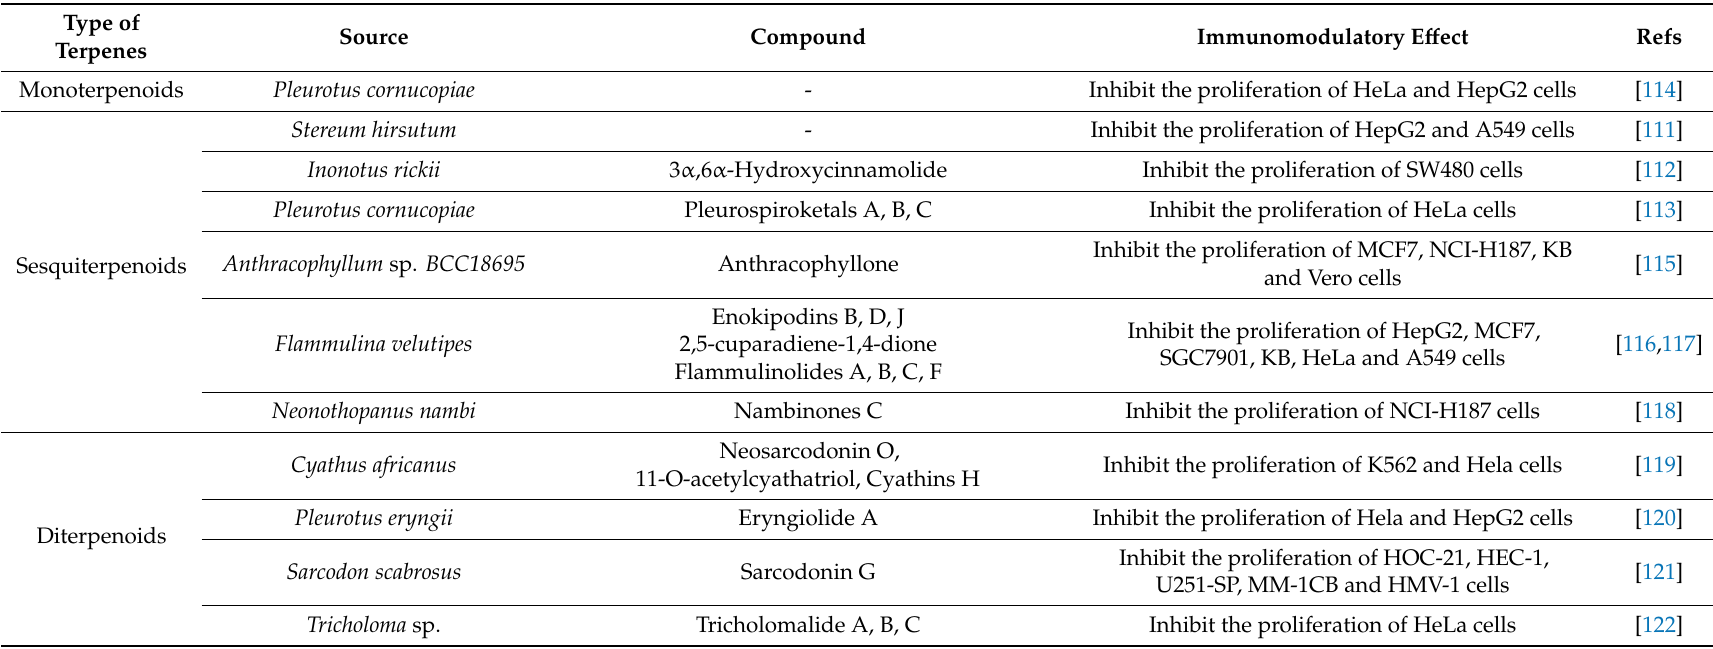
Table 5. Major immunomodulatory terpenes and terpenoids from medicinal mushrooms and their immunomodulatory e ff ects. Type